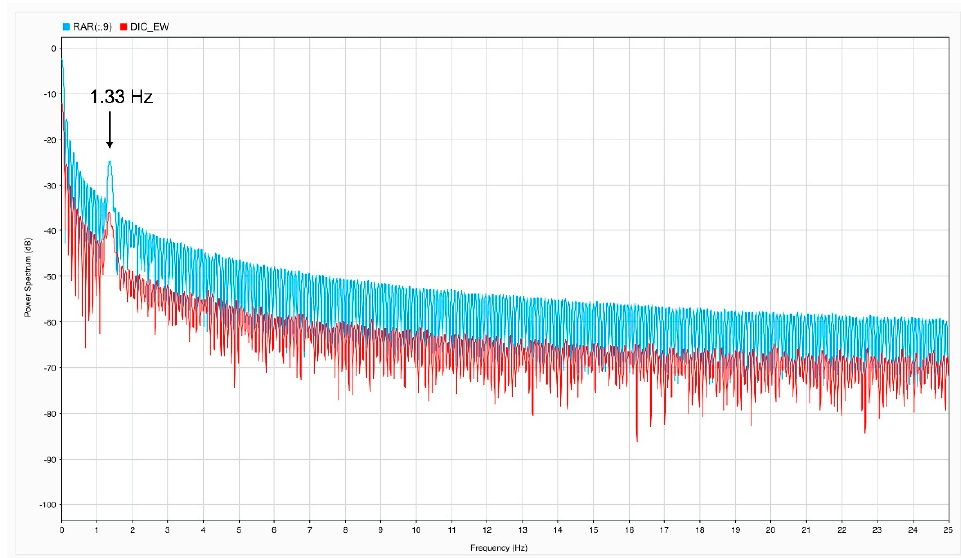
Figure 20. Signal comparison: RAR and DIC spectrum .